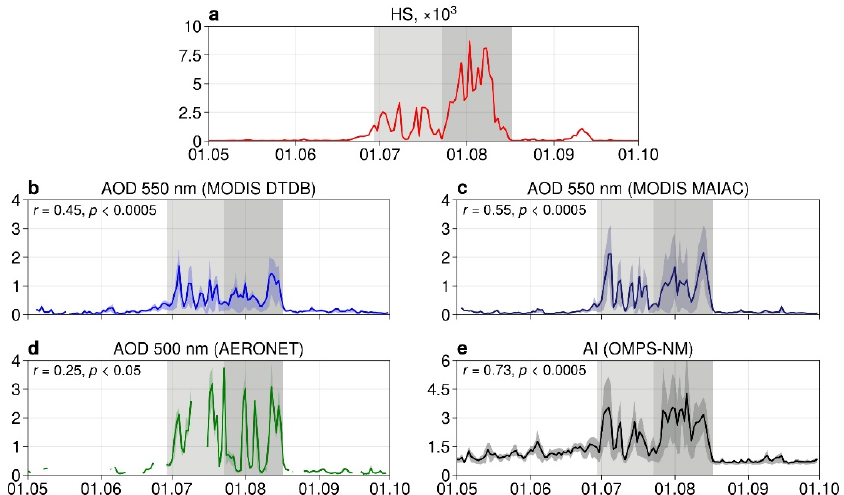
Figure 5. ( a ) MODIS hotspots; ( b ) AOD at 550 nm from MODIS DTDB algorithm; ( c ) AOD at 550 nm from MODIS MAIAC algorithm; ( d ) AOD at 500 nm from AERONET sun photometer at Yakutsk; ( e ) aerosol index from OMPS-NM. Grey vertical bars indicate two periods of wildfire activity. Shaded areas on figures ( b – e ) indicate a 25–75 percentile range. Figures ( b , c , e ) represent mean values over the study region. Correlation coefficients on figures ( b – e ) indicate correlation between the number of HS and the corresponding parameter during the period from 1 May to 30 September.